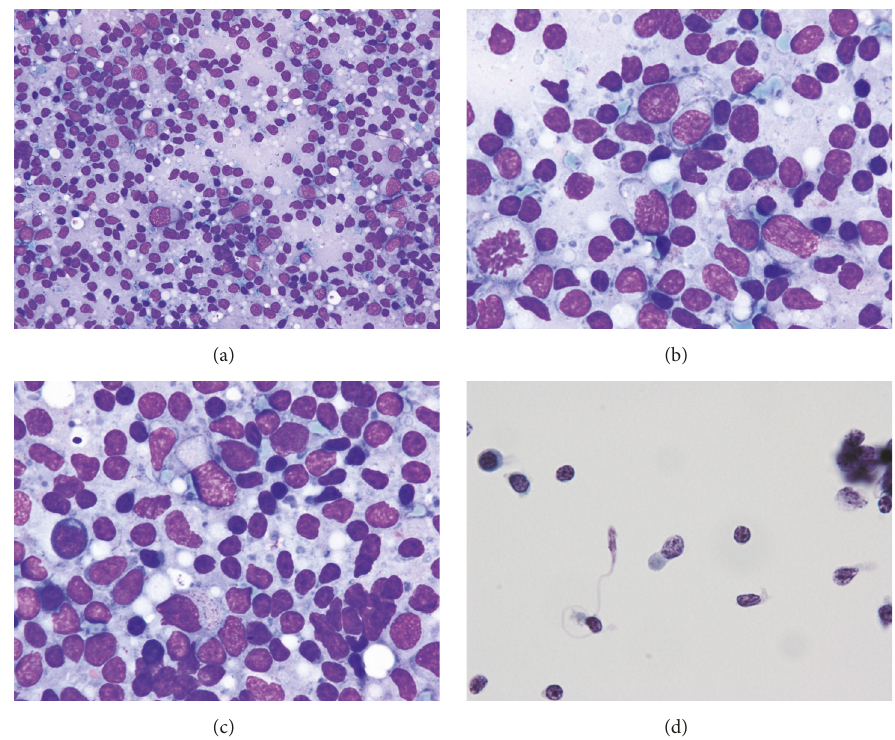
Figure 3: FNAC of the left neck lymph node. (a) Lymphoid cells varying in size and shape (Liu’s stain, 400x). (b, c) Intermediate to large cells with irregular nuclei, central nucleoli, tongue-like cytoplasmic protrusions, and fine or coarse azurophilic granules (Liu’s stain, 1000x). (d) Cytoplasmic protrusions are visible in LBC (Pap stain,